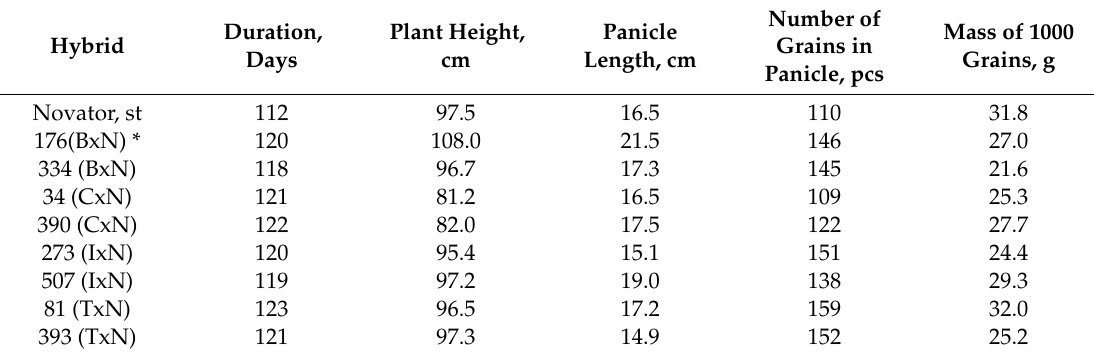
Table 3. Selected F 2 hybrid plants from crossing submergence-resistant samples with Novator, 2014. Hybrid